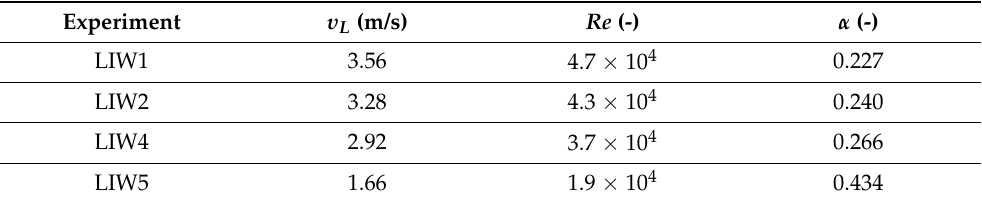
Table 2. Basic parameters of flows for the analyzed experiments: υ L —water velocity, Re —Reynolds number, α —void fraction.